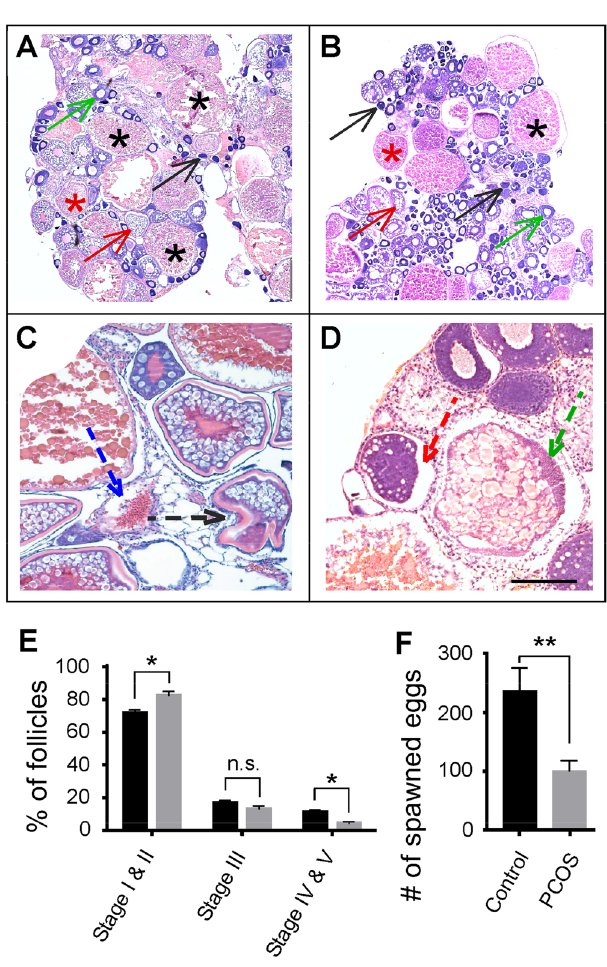
Figure 2. Follicle development and ovulation in control and PCOS zebrafish. ( A , B ) Histological sections of the ovary. In control fish ( A ), follicles at different stages could be identified. These include developing follicles (Stages I and II, black and green arrows), transitioning follicles (Stage III, red arrows), and mature follicles (Stages IV and V, red and black asterisks). In PCOS fish ( B ), more developing follicles but less mature follicles were observed. ( C , D ) Histological sections that show abnormal follicles in PCOS fish. These include zona pellucida invagination (black arrow), theca hypertrophy/granulosa cell invagination (blue arrow), basal membrane disintegration (red arrow), and basophilic granular accumulation (green arrow). Scale bar: 100 µm in panels ( A ) and ( B ), and 50 µm in panels ( C ) and ( D ). ( E ) Percentage of developing, transitioning, and mature follicles in control (black bars) and PCOS fish (grey bars). Note the increase of developing follicles and the decrease of mature follicles in PCOS animals. ( F ) Ovulation in control (black bar) and PCOS (grey bar) zebrafish. Note the decrease of ovulation in PCOS fish. Data represents the means ± SE (n = 8 in each group). *p < 0.05; **p < 0.01; ns not